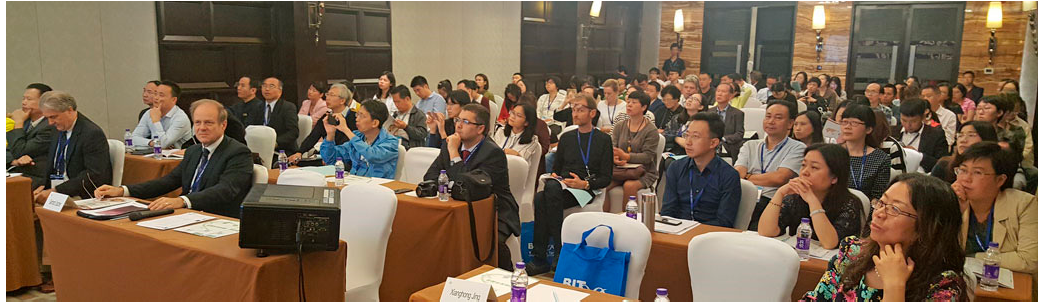
Figure 1. 4th Annual World Congress of High-Tech Acupuncture and Integrative Medicine—2017 in Xi’an, China.